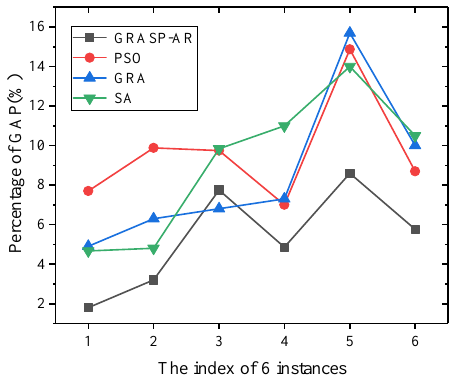
Figure 4. GAP fitting curve of real-world dataset under different gain-cost